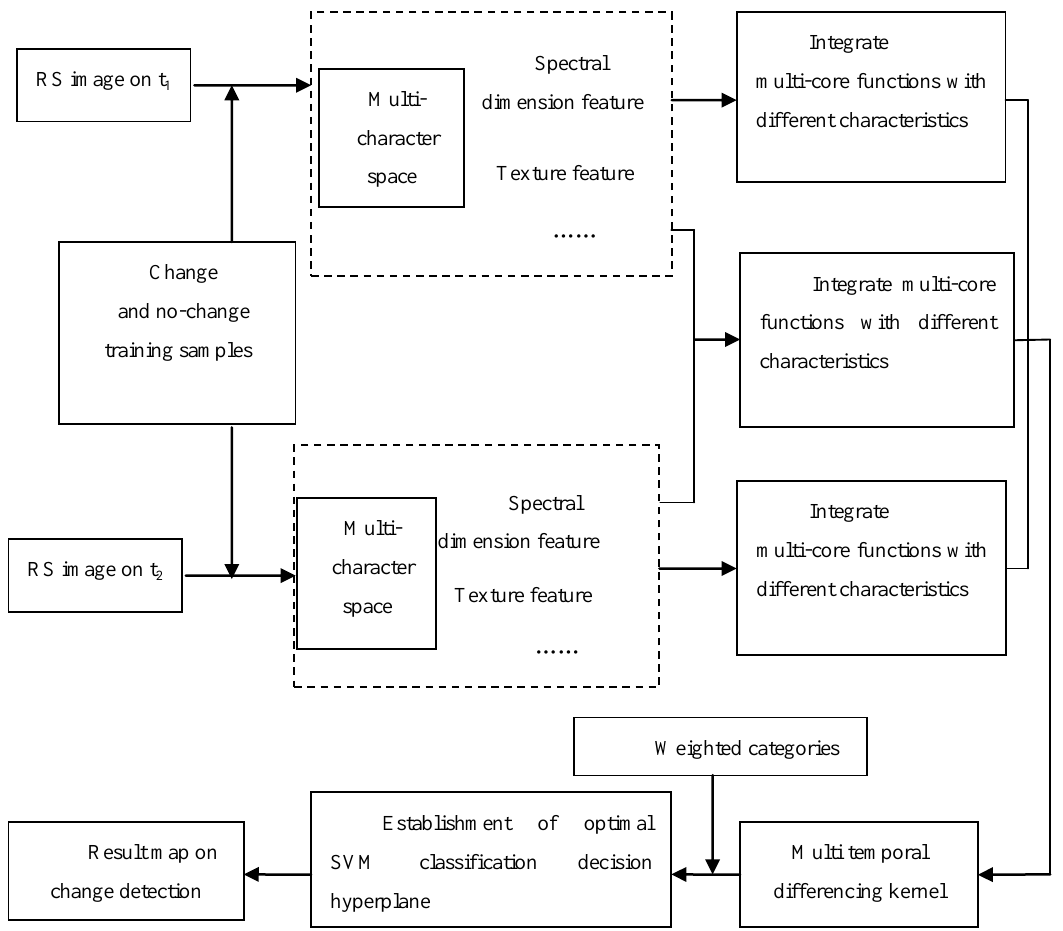
Fig.1 Flow chart of Multi-Feature Differencing Kernel SVM change detection